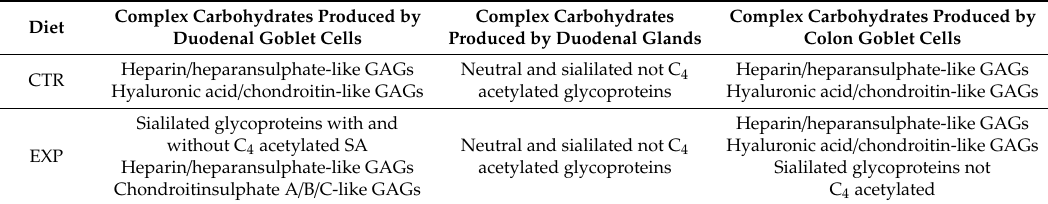
Table 5. Complex carbohydrates produced by analyzed secretory structures under di ff erent dietary